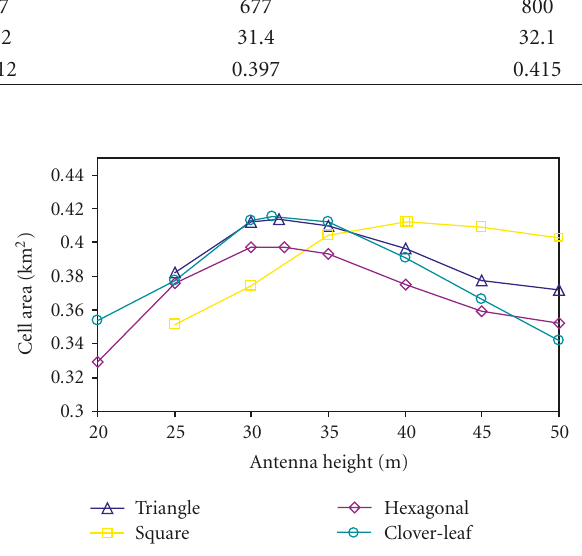
Figure 7: E ff ect of the antenna height on average SIR at dominance area border for di ff erent layouts.